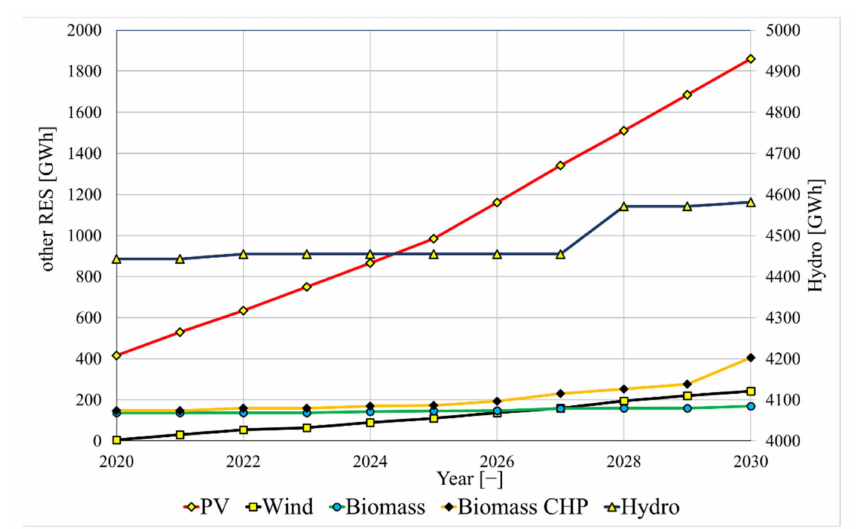
Figure 5. Assumed RES uptake in Slovenia from 2020 to 2030 according to NECP